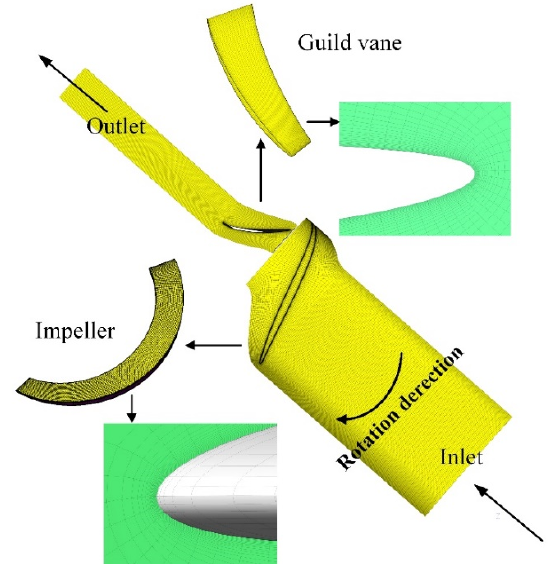
Figure 3. Grids for the numerical simulation the multiphase pump.